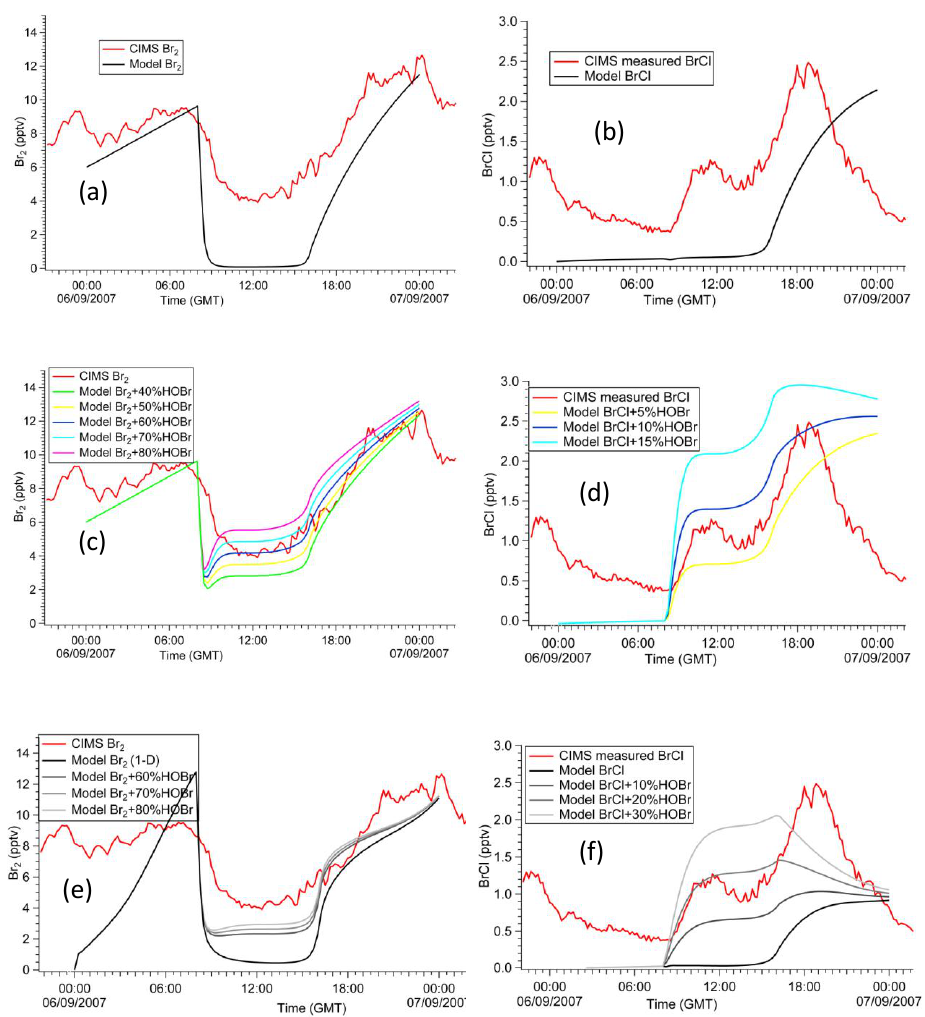
Fig. 3. (a) comparison between Br 2 measured with CIMS and that modelled with MISTRA-0D for 6 and 7 September 2007; (b) as for (a) but this time showing BrCl; (c) comparison between Br 2 measured with CIMS, and that modelled with MISTRA-0D, but now with 40%, 50%, 60%, 70%, and 80% of model HOBr added to model Br 2 ; (d) as for (c) but with 5%, 10% and 15% of model HOBr added to model BrCl; (e) comparison between Br 2 measured with CIMS and that modelled with MISTRA-1D, with 60%, 70% and 80% of model HOBr added to model Br 2 ; (f) as for (e) but with 10%, 20% and 30% of model HOBr added to model BrCl. Both 1-D model outputs (e) and (f) correspond to a height of 4.5–7.5m above the